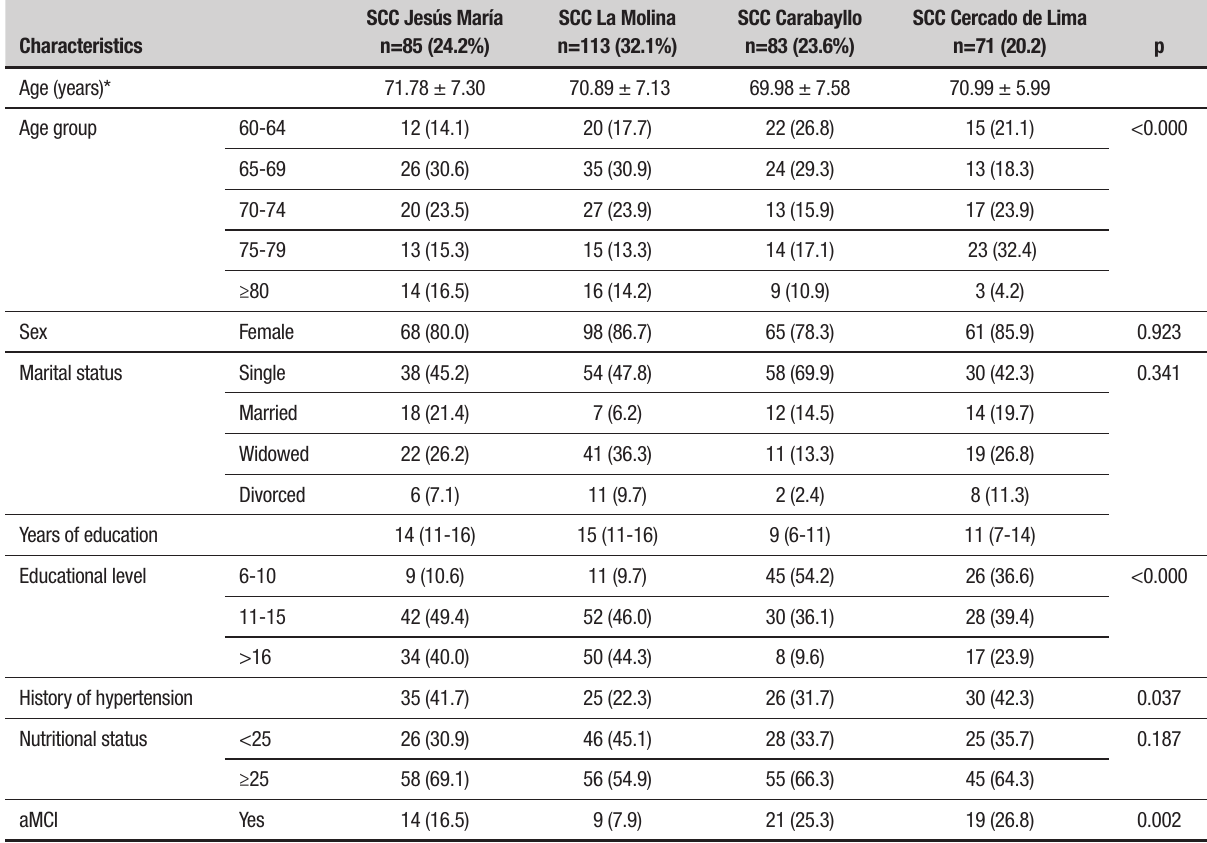
Table 4. Characteristics of study participants by SCC location.